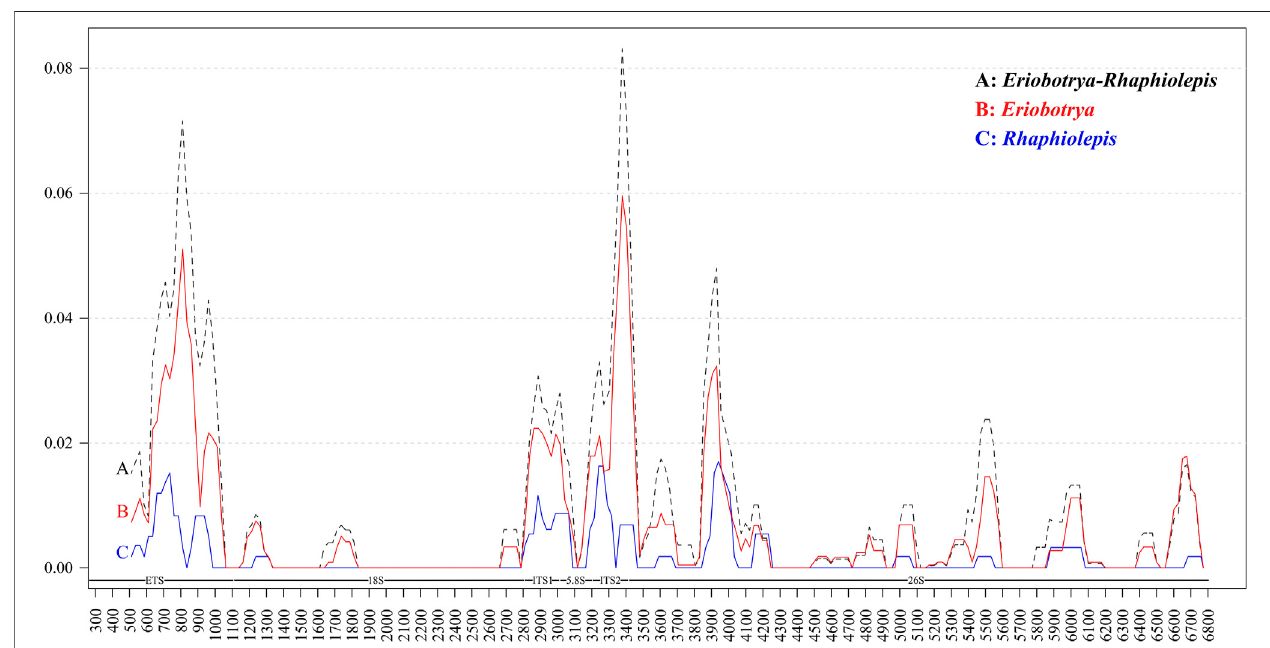
FIGURE 2 | Sliding window analysis of the nrDNA of Eriobotrya and Rhaphiolepis (A) , Eriobotrya (B) , and Rhaphiolepis (C) . (window length: 100 bp, step size: 50 bp). x axis, position of the midpoint of the window; y axis, nucleotide diversity of each window.